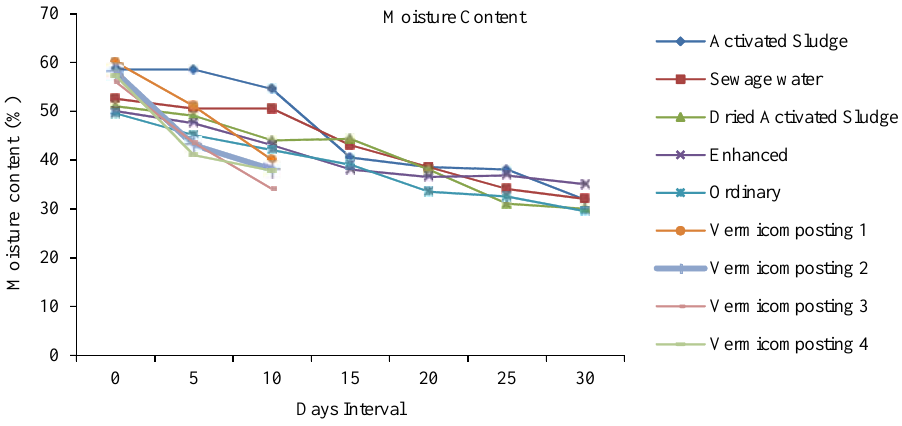
Fig. 3: Comparison of moisture content between various compost samples